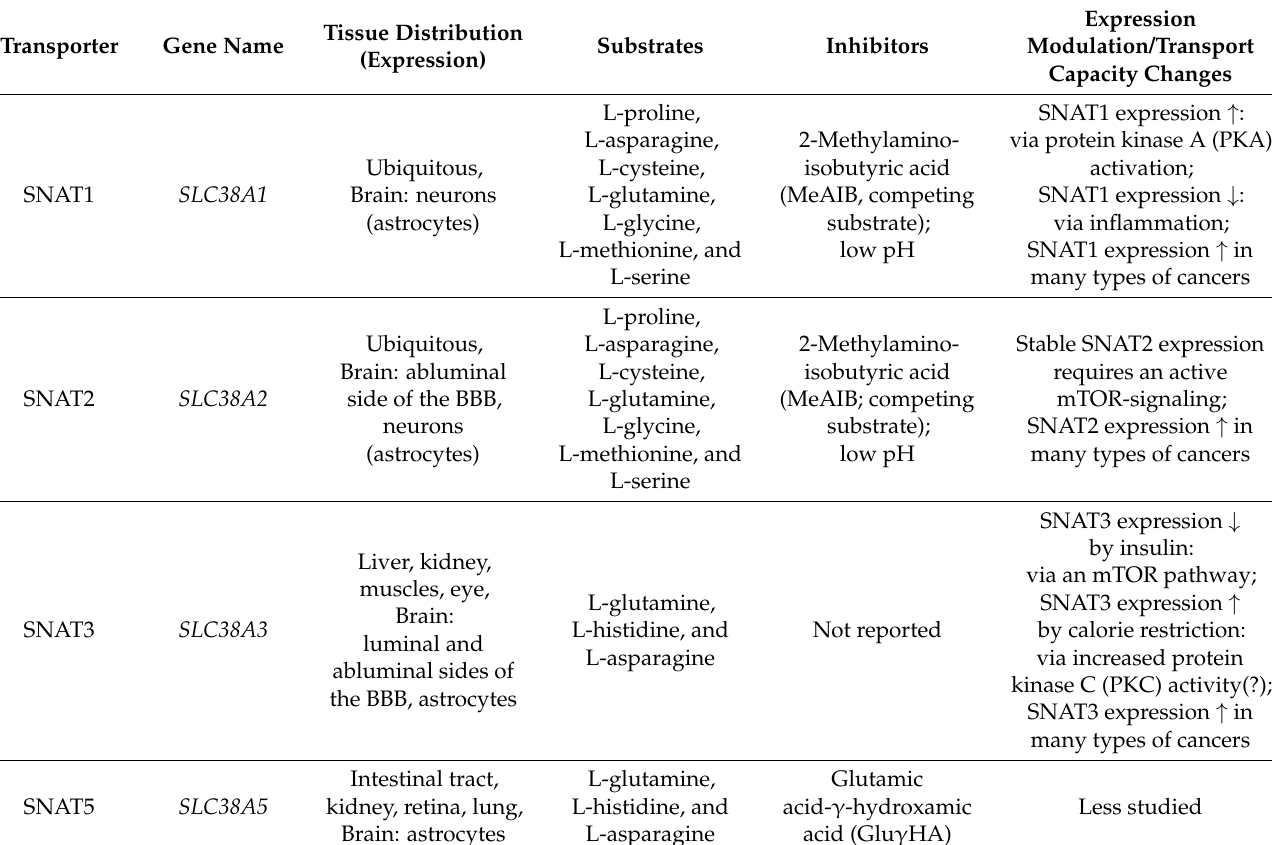
Table 7. Tissue distribution, substrates, inhibitors, and expression/function modulators of SNAT1–2 (system A) and SNAT3 and 5 (system